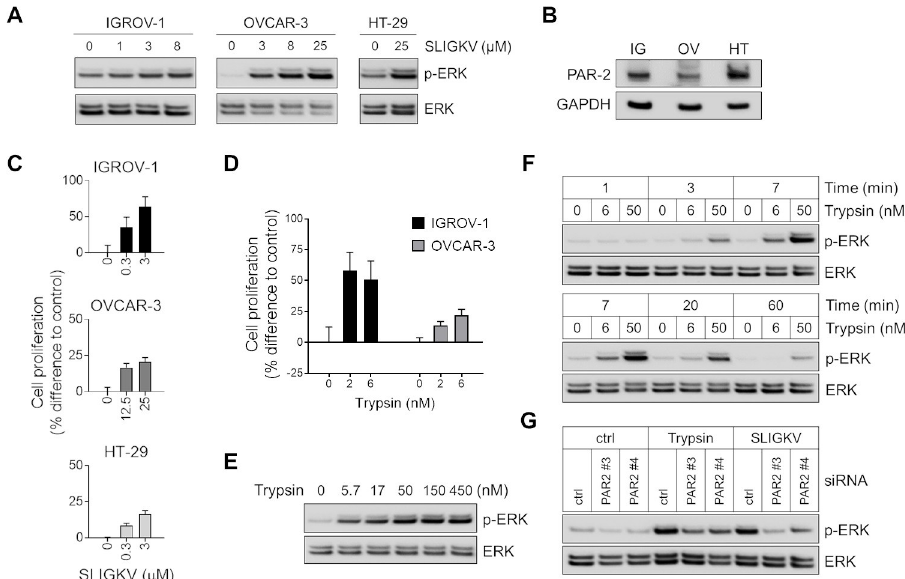
Fig 2. PAR2 agonist and trypsin induce PAR2 signaling in ovarian cancer cell lines. (A) Cancer cells were stimulated with PAR2 activating peptide (SLIGKV-NH 2 ) for 7 min. The levels of ERK or phosphorylated ERK were measured by Western blot analysis. (B) Expression of PAR2 in cancer cell lines was determined by Western blot analysis. IG: IGROV-1, OV: OVCAR-3, HT: HT-29. (C) Cancer cells were stimulated with SLIGKV-NH 2 for 96 h (OVCAR-3 and HT-29) or 120 h (IGROV-1), after which cell proliferation was measured by MTS assay. (D) Ovarian cancer cell lines were stimulated with trypsin at the indicative concentrations for 96 h, after which cell proliferation was measured by MTS assay. (E) OVCAR-3 cells were stimulated with trypsin for 7 min at the indicated concentrations. (F) OVCAR-3 cells were stimulated with the fixed concentrations of trypsin (6 or 50 nM) for the duration as indicated. (G) PAR2 knockdown in OVCAR-3 cells was achieved by transient transfection with siRNAs targeting PAR2 or with non-targeting control siRNA (50 nM). At 48 h post transfection cells were serum starved for 6 h and stimulated with either trypsin (6 nM) or SLIGKV (3 μ M) for 7 min. The levels of ERK or phosphorylated ERK were determined by Western blot analysis.